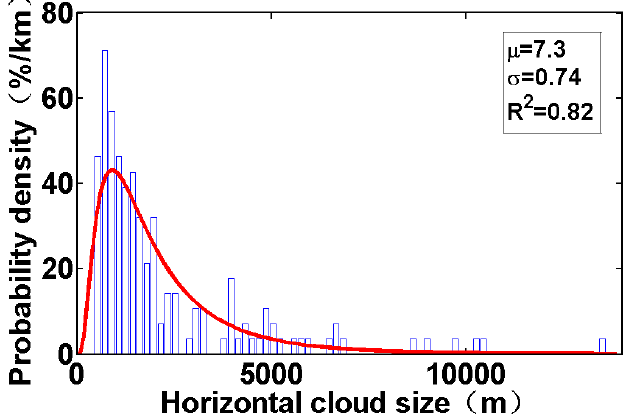
Figure 1. Probability density function of horizontal cloud size. The red line is fitted lognormal distribution. Mean ( μ ), standard deviation ( σ ) of the logarithm of horizontal cloud size and coefficients of determination (R 2 , a statistical measure of how well the regression line approximates the real data points) for the lognormal fit are also